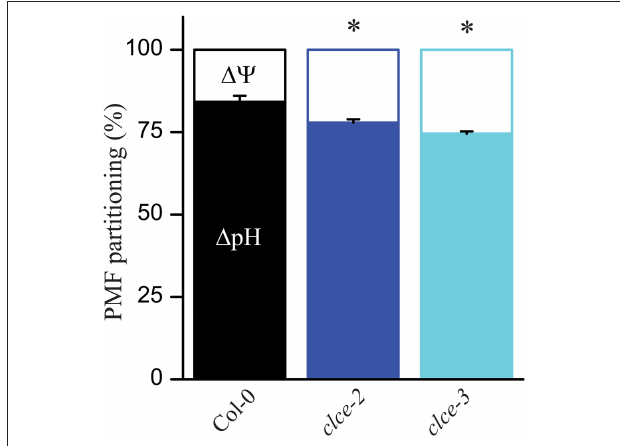
10min with 650 µ mol photons m − 2 s − 1 . Following illumination, kinetics of dark relaxation of the electrochromic shift (ECS) signal were recorded and deconvoluted to determine membrane pH gradient ( 1 pH) and membrane potential ( 19 ) components. The plotted data are means ± SEM ( n = 8 –9 plants). Asterisks indicate statistically significant differences according to ANOVA ( P < 0.05 ).